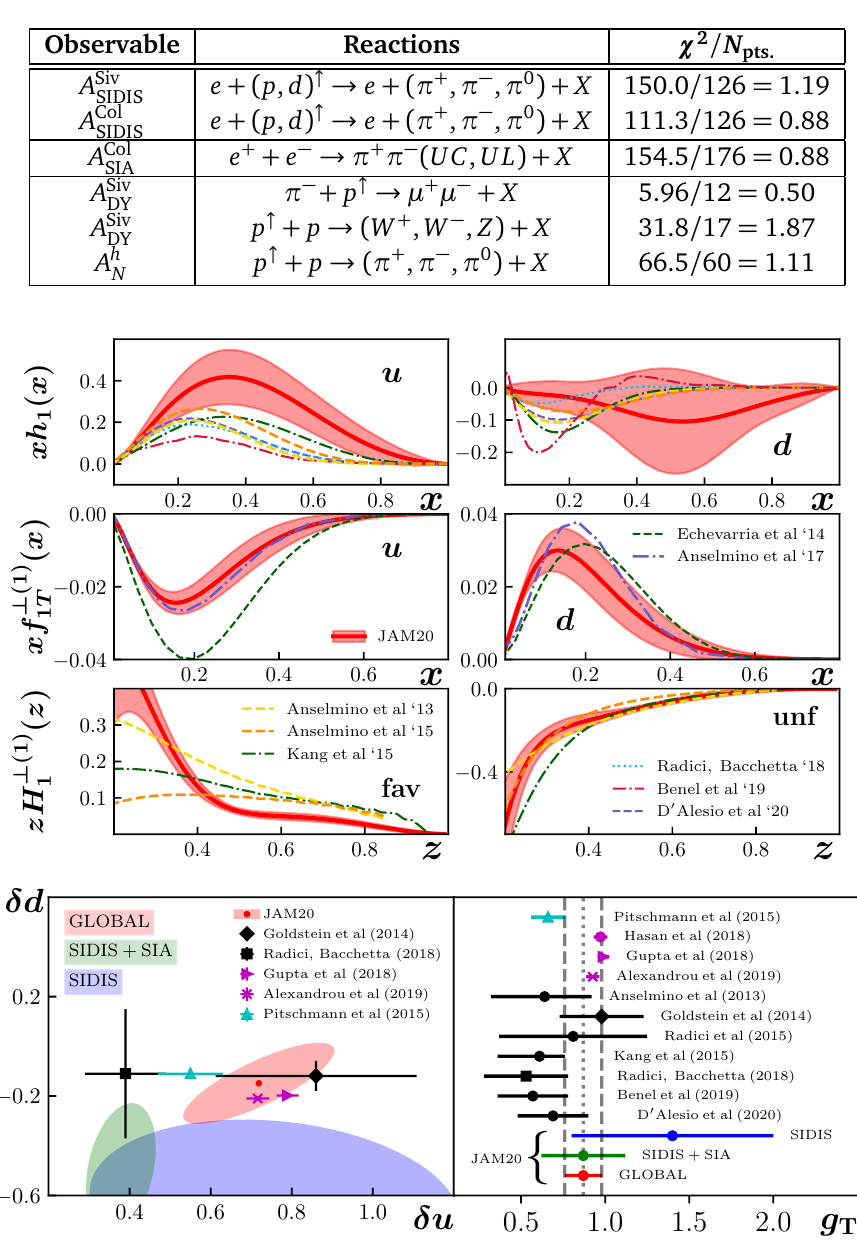
Table 1: Summary of the SSAs analyzed in our global fit and the χ 2 / N for each observable.